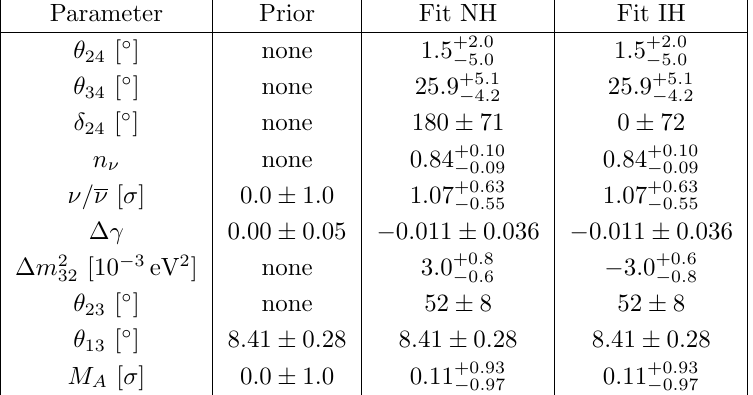
Table 3 . Priors and (cid:12)tted values obtained from the minimisation for all the parameters considered in the sterile oscillation